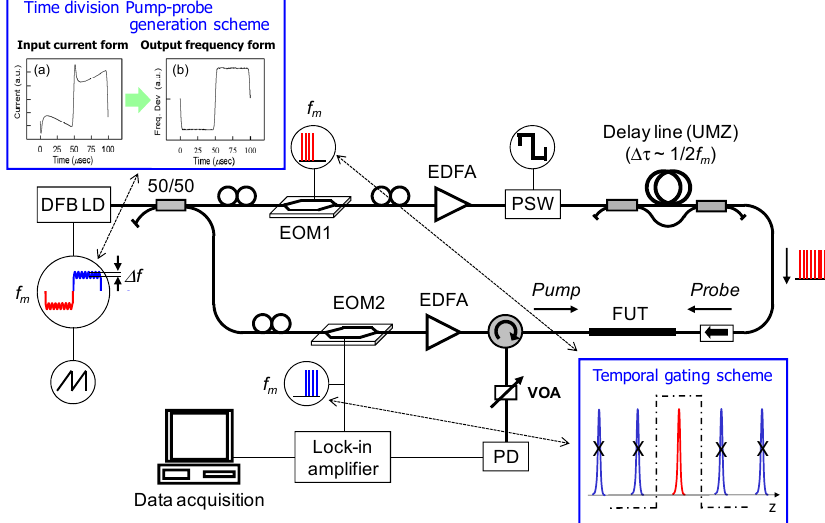
Figure 27. BOCDA system that has the temporal gating scheme and the time-division pump and probe generation scheme [54].